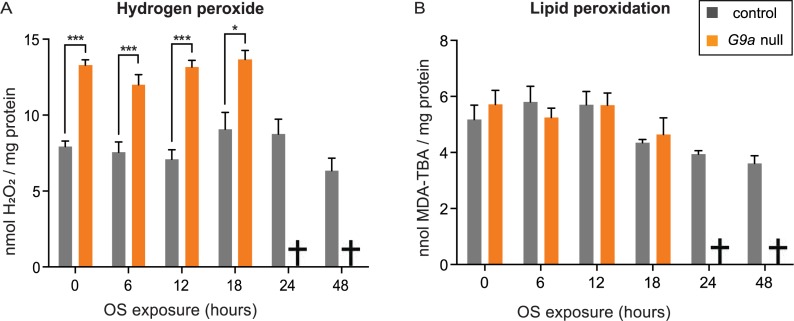
No accumulation of ROS or ROS-mediated damage during OS exposure in G9a mutants and controls.(A) Hydrogen peroxide and (B) lipid peroxidation levels in G9a mutants and controls over a time course of OS exposure. Measurements could not be obtained for the G9a mutants at 24 and 48 h time points, as most flies were already dead (indicated by cross). Bar graphs showing mean values and SEM were generated using Graphpad, and p-values were obtained using multiple t tests with FDR correction. ***p < 0.001; *p < 0.05. The numerical data depicted in this figure can be found in S5 Data. FDR, false discovery rate; OS, oxidative stress; ROS, reactive oxygen species; MDA, malondialdehyde.